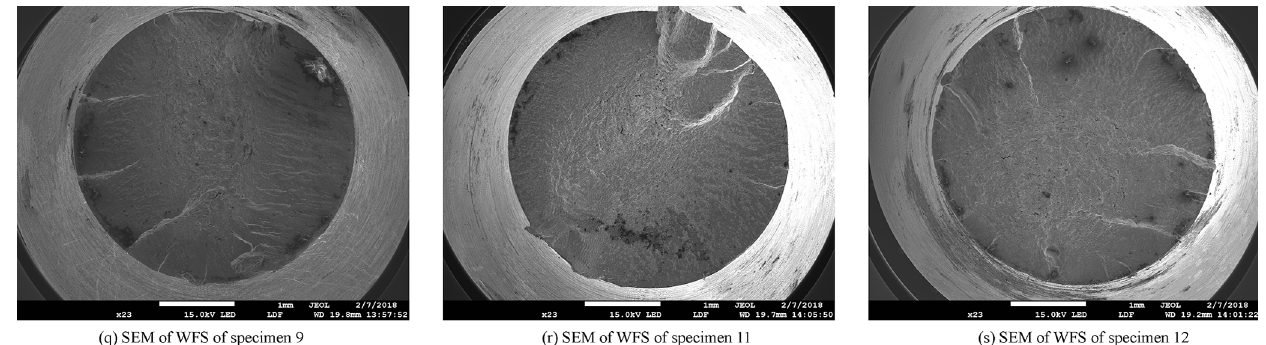
Figure 6. Scanning electron micrographs of the whole and local fracture surface of those specimens listed in Table 4. (a) SEM of WFS of specimen 1, (b) SEM of LFS of specimen 1, (c) SEM of WFS of specimen 2, (d) SEM of LFS of specimen 2, (e) SEM of WFS of specimen 5, (f) SEM of LFS of specimen 5, (g) SEM of WFS of specimen 3, (h) SEM of LFS of specimen 3, (i) SEM of WFS of specimen 4, (j) SEM of LFS of specimen 4, (k) SEM of WFS of specimen 6, (l) SEM of LFS of specimen 6, (m) SEM of WFS of specimen 7, (n) SEM of LFS of specimen 7, (o) SEM of WFS of specimen 8, (p) SEM of LFS of specimen 8, (q) SEM of WFS of specimen 9, (r) SEM of WFS of specimen 11, (s) SEM of WFS of specimen 12.